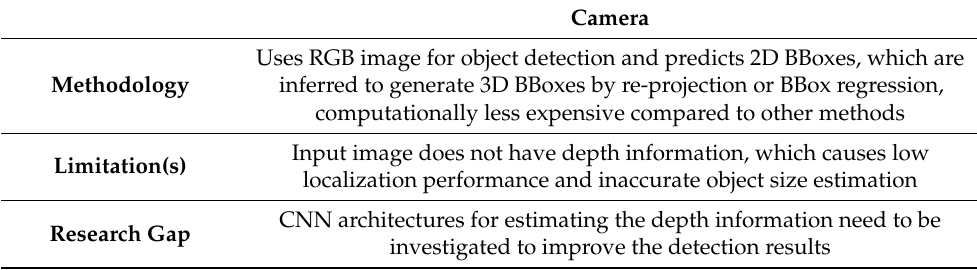
Table 8. Methodology and Limitations: Camera-based 3DOR.